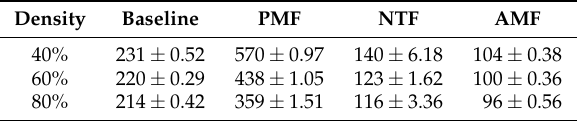
Figure 3. Illustrative interval of estimation of response time of proxy 5 from client 6, using the matrix factorization and baseline algorithms, with 60% density. Table 4. Average and standard deviation of the mean average error (MAE) for the baseline algorithm as well as probabilistic matrix factorization (PMF), non-negative tensor factorization (NTF) and adaptive matrix factorization (AMF), with different densities of sampling of the dataset. Values are in